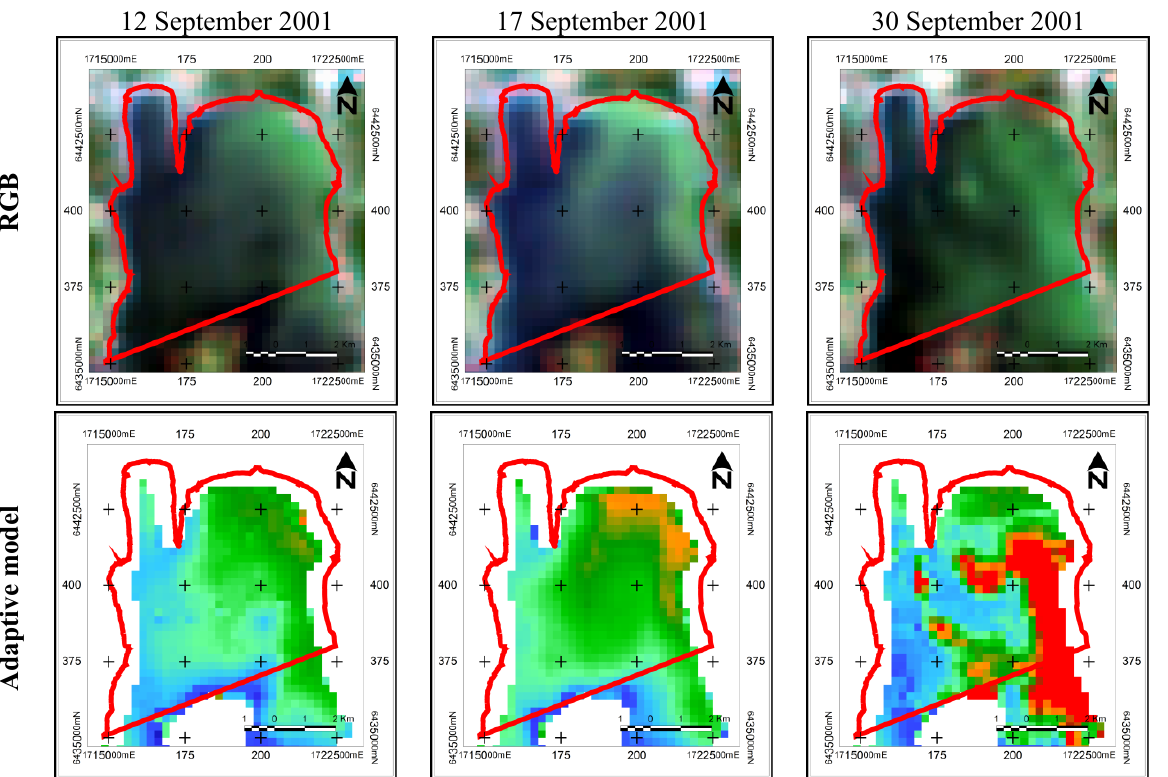
Figure 11. Application of the four models (AM, APPEL , FAI , and Kahru ) to a series of MODIS images collected during the establishment of a HAB on Missisquoi Bay, Lake Champlain, compared to the true color composite images (RGB for red, green, blue). The red polygon indicates the shoreline and southern boundary of the bay. Chlorophyll-a concentrations are on a Napierian logarithmic